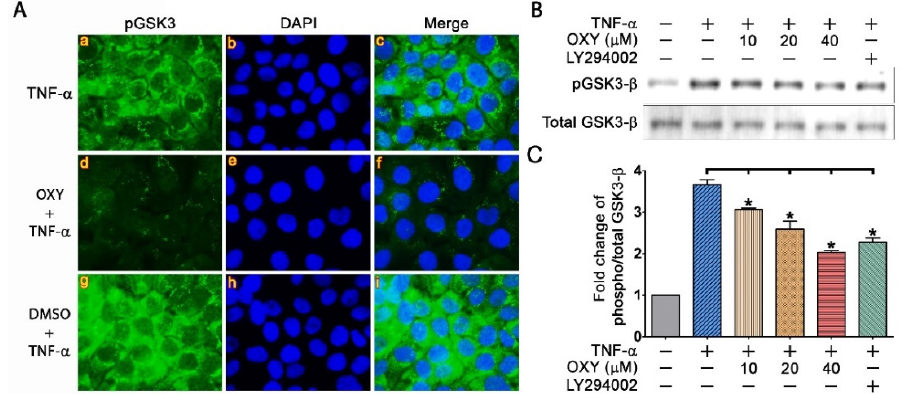
Figure 5. Effects of OXY on blocking TNF- α -stimulated GSK3- β phosphorylation. ( A ) Immunofluo- rescence study detecting pGSK3- β (green) in individual cells treated with 40 µ M for 3 h and stimulated with 100 ng/mL TNF- α for 20 min. Nuclei were counterstained with DAPI (blue), visualization was performed at 100 × magnification. ( B ) Western blot analysis showing dose-dependent effects of OXY on suppressing GSK3- β phosphorylation. LY294002, a PI3K inhibitor, was used as a positive